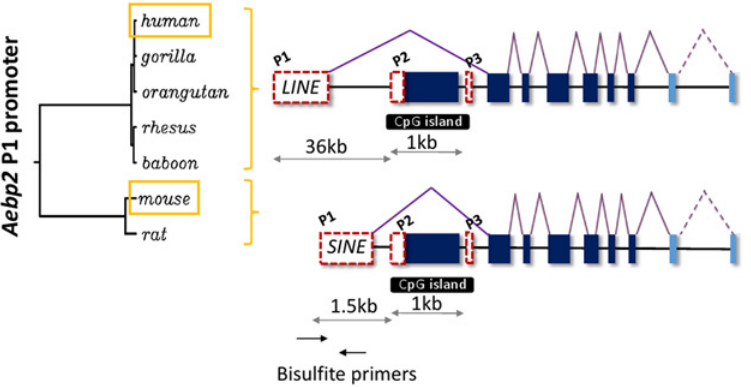
Fig 1. Retrotransposon-derived P1 promoter of human and mouse Aebp2 . The phylogeny tree shown left was generated using the genomic sequences corresponding to the P1 promoter regions of five primate and two rodent species. The exon structures of human and mouse Aebp2 are shown right: the dotted red boxes indicate three promoters whereas the closed boxes indicate